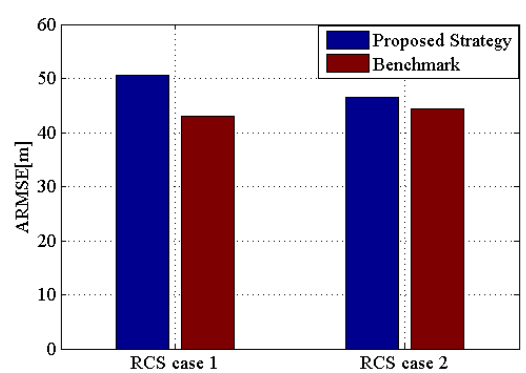
Figure 12. Average root mean square error (ARMSE) comparison of two algorithms for target tracking.